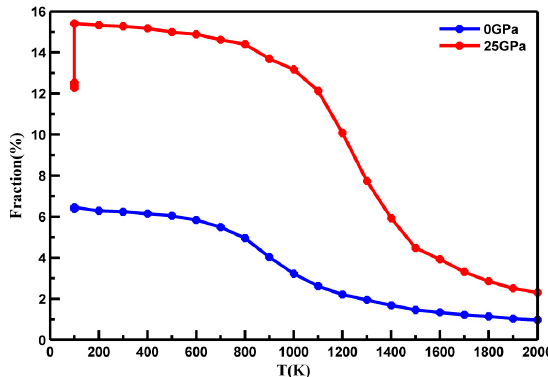
Figure 4. The number of full icosahedra (FI) as a function of temperature at different pressures.